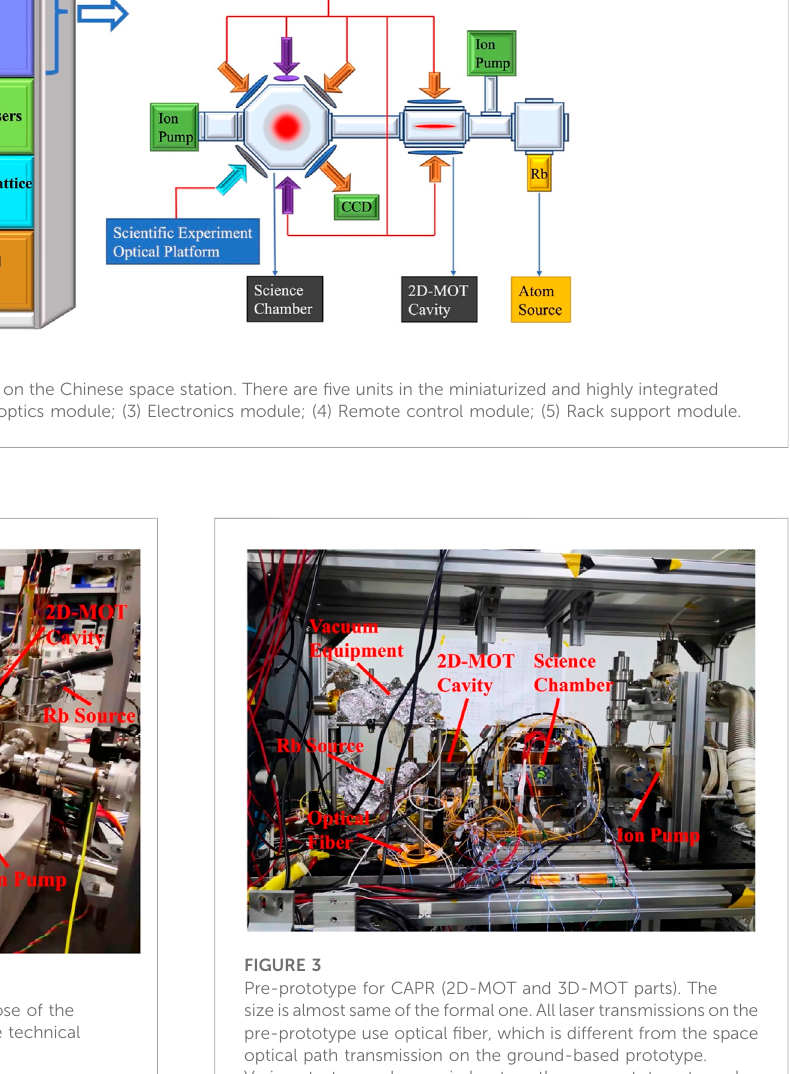
volume and high power consumption of the traditional AOM complex optical path. The complex programmable logic device (CPLD) is used to replace the LabVIEW board card (not available in space) to realize the control of system time sequence. It is just a 10 cm × 10 cm circuit board programmed through a computer, which realize the switch control of shutter driver, AOM driver, magnetic coil driver, laser power variation curve of optical dipole trap, camera trigger and so on. And high current magnetic trap control technology enables a high-current coil to have a current of 500 A and a magnetic fi eld of 600 Gs.